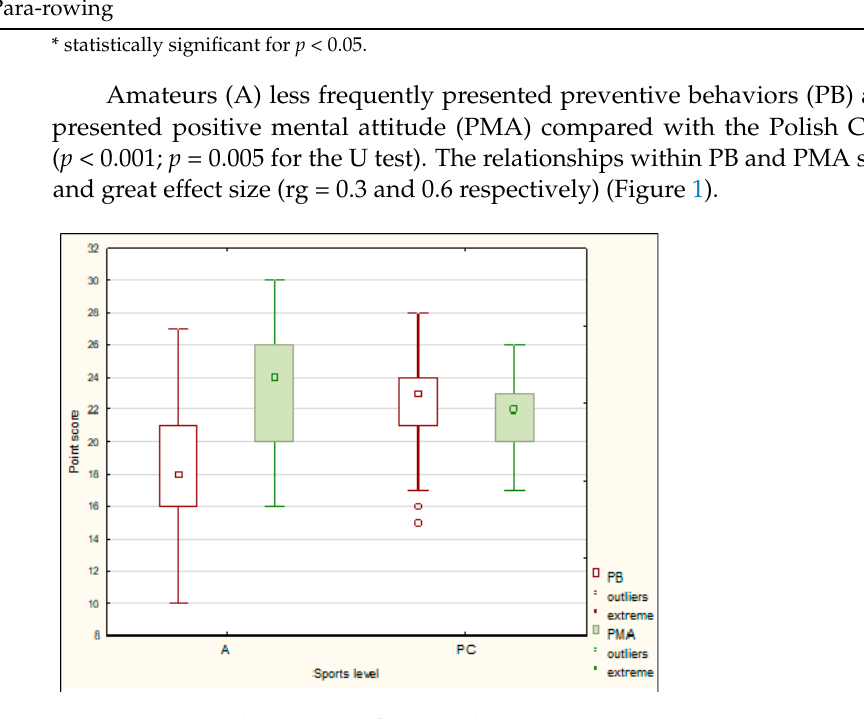
Figure 1. The health behaviors of the Polish Champions (PC) and the amateurs (A). The best results in HBI and in the CEH, PMA and HP categories were reported among people with the longest weekly exercise time (>360 min), while the worst ones were among people exercising less than 120 min ( p = 0.018, p = 0.014, p = 0.013, and p = 0.009 for the U test, respectively). People who devoted less time to exercise also achieved poorer results (PMA, HP) than those who exercised 121–240 min ( p = 0.006 and p = 0.037 for the U test, respectively). These differences are confirmed by the mean and effect size (rg = − 0.3; 0.4) above the mean. People exercising less than 120 min a week had better results in PB than did those who exercised 121–240min ( p = 0.035 for the U test), who in turn had weaker results when compared with those who exercised 241–360min ( p = 0.035 for the U test) (Table 3). Table 3. Health behaviors of people practicing wheelchair basketball, wheelchair rugby and para- rowing depending on the weekly exercise time (the H test, E 2R , the U test, rg). HBI and Its Cate- gories